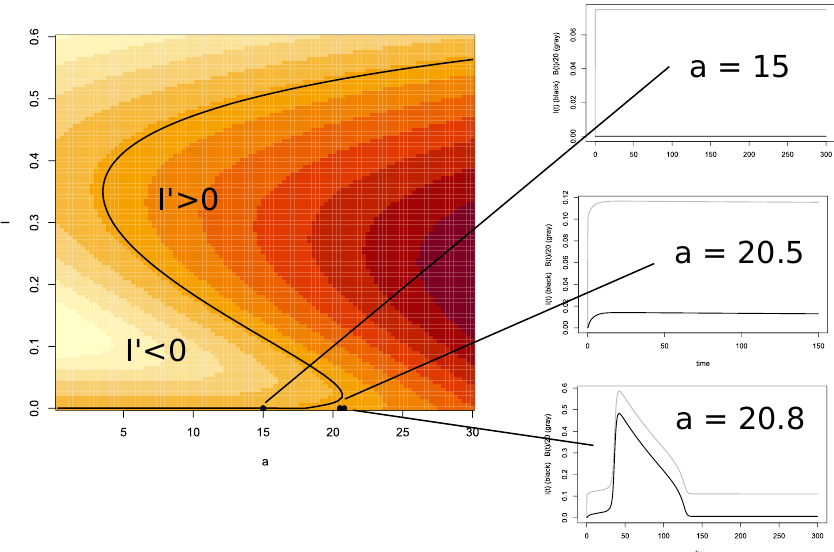
Figure 4. Left: I (cid:48) = F ( a , I ) , right: three simulations differing in the choice of a . Black: I ( t ) , gray: B ( t ) /20 ( B is scaled to be comparable with the prevalence). Parameter values are given in the Appendix